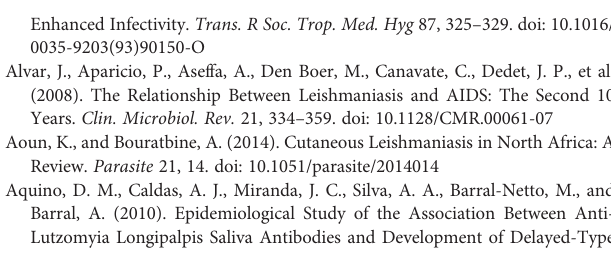
Supplementary Figure 1 | Linearity assessment and limit of detection of the L. major kDNA as a function of the number of ng of parasitic puri fi ed DNA panel (A) , the number of added promastigotes panel (B) or amastigotes panel (C) parasite forms to human PBMC, shuman skin or mouse skin. Means of Ct